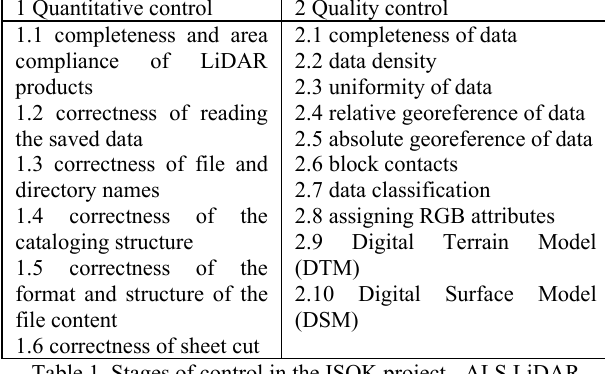
Table 1. Stages of control in the ISOK project - ALS